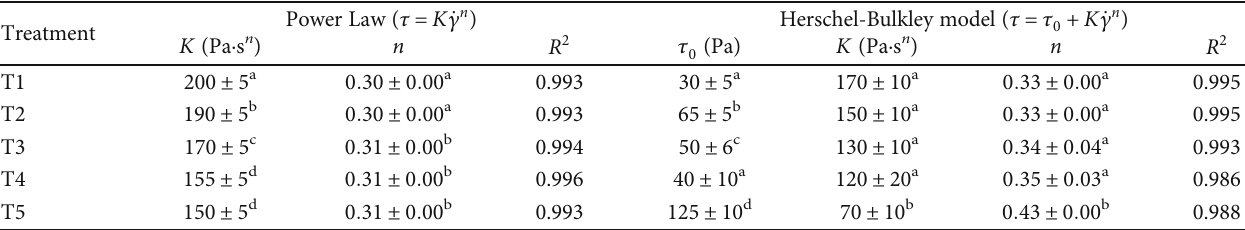
Table 3: Flow parameters from the Power Law and Herschel-Bulkley models for wheat dough, ackee aril dough, and wheat-ackee aril dough